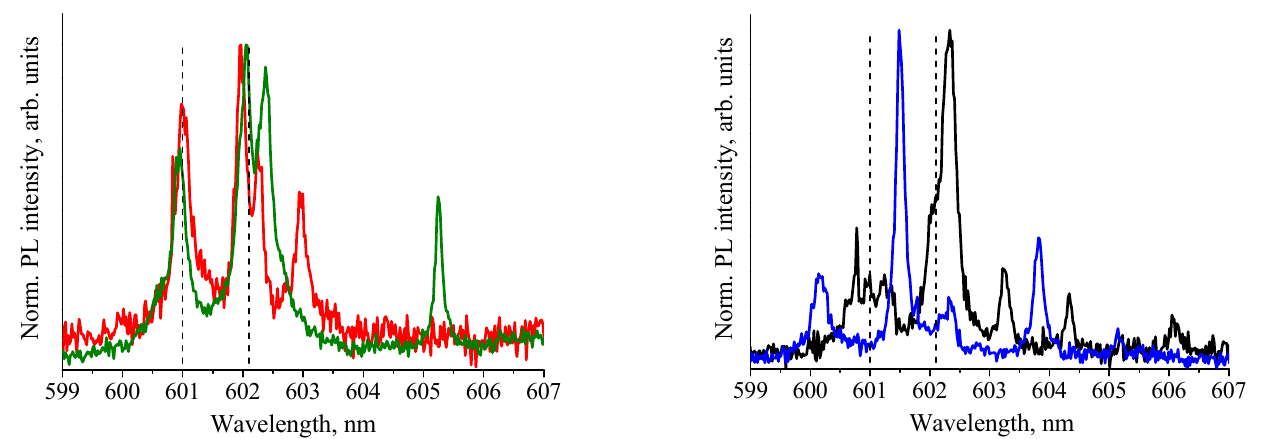
Figure 5. High-resolution ZPL spectra of the ensembles of GeV − color centers for various etched nanodiamonds demon- strating markedly different spectral positions and intensities of the ZPL doublets. The spectra were recorded at T = 80 K. The vertical lines show the spectral positions of the ZPL doublet of GeV − centers for microcrystal diamond with high crystalline quality at T = 77 K [12].